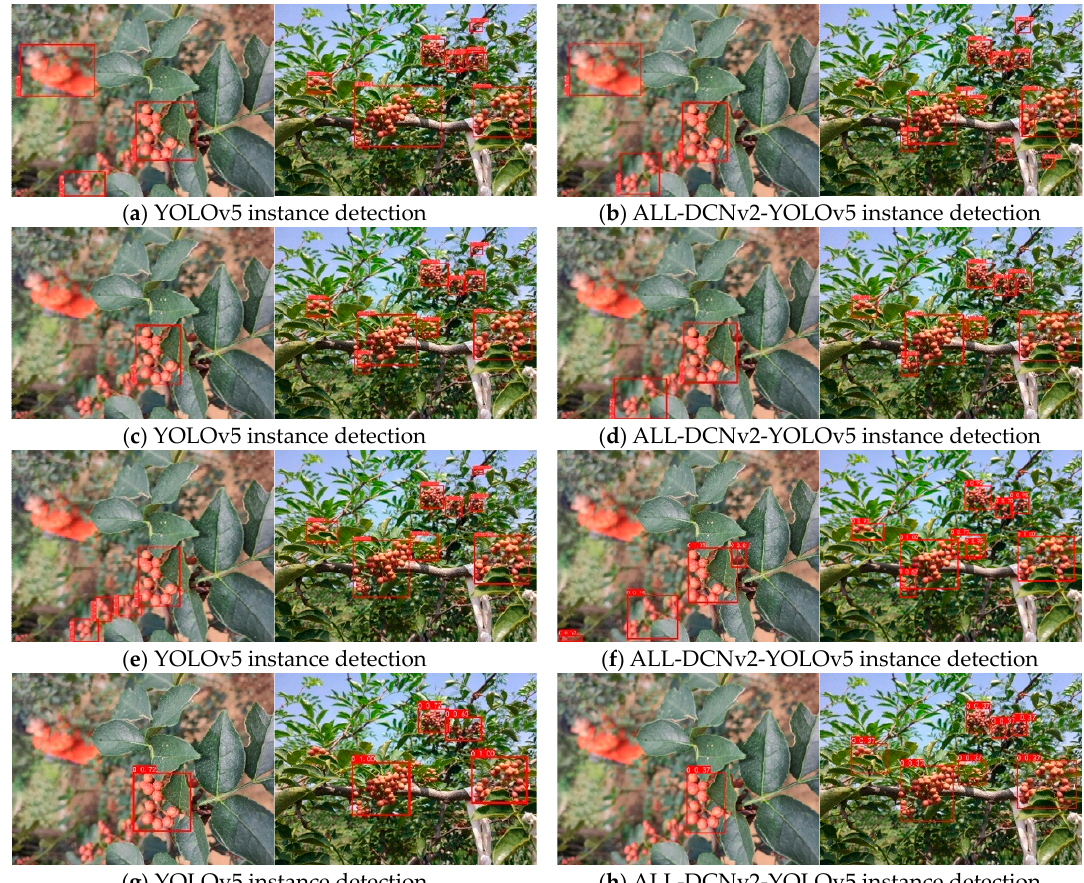
Figure 12. Comparison of partial test results of different models. ( a ) YOLOv5 instance detection; ( b ) ALL-DCNv2-YOLOv5 instance detection; ( c ) CA-YOLOv5 instance detection; ( d ) DCNv2-YOLOv5 instance detection; ( e ) CA-DCNv2-YOLOv5 instance detection; ( f ) Fsater R-CNN instance detection; ( g ) m SSD instance detection; ( h ) Centernet instance detection.